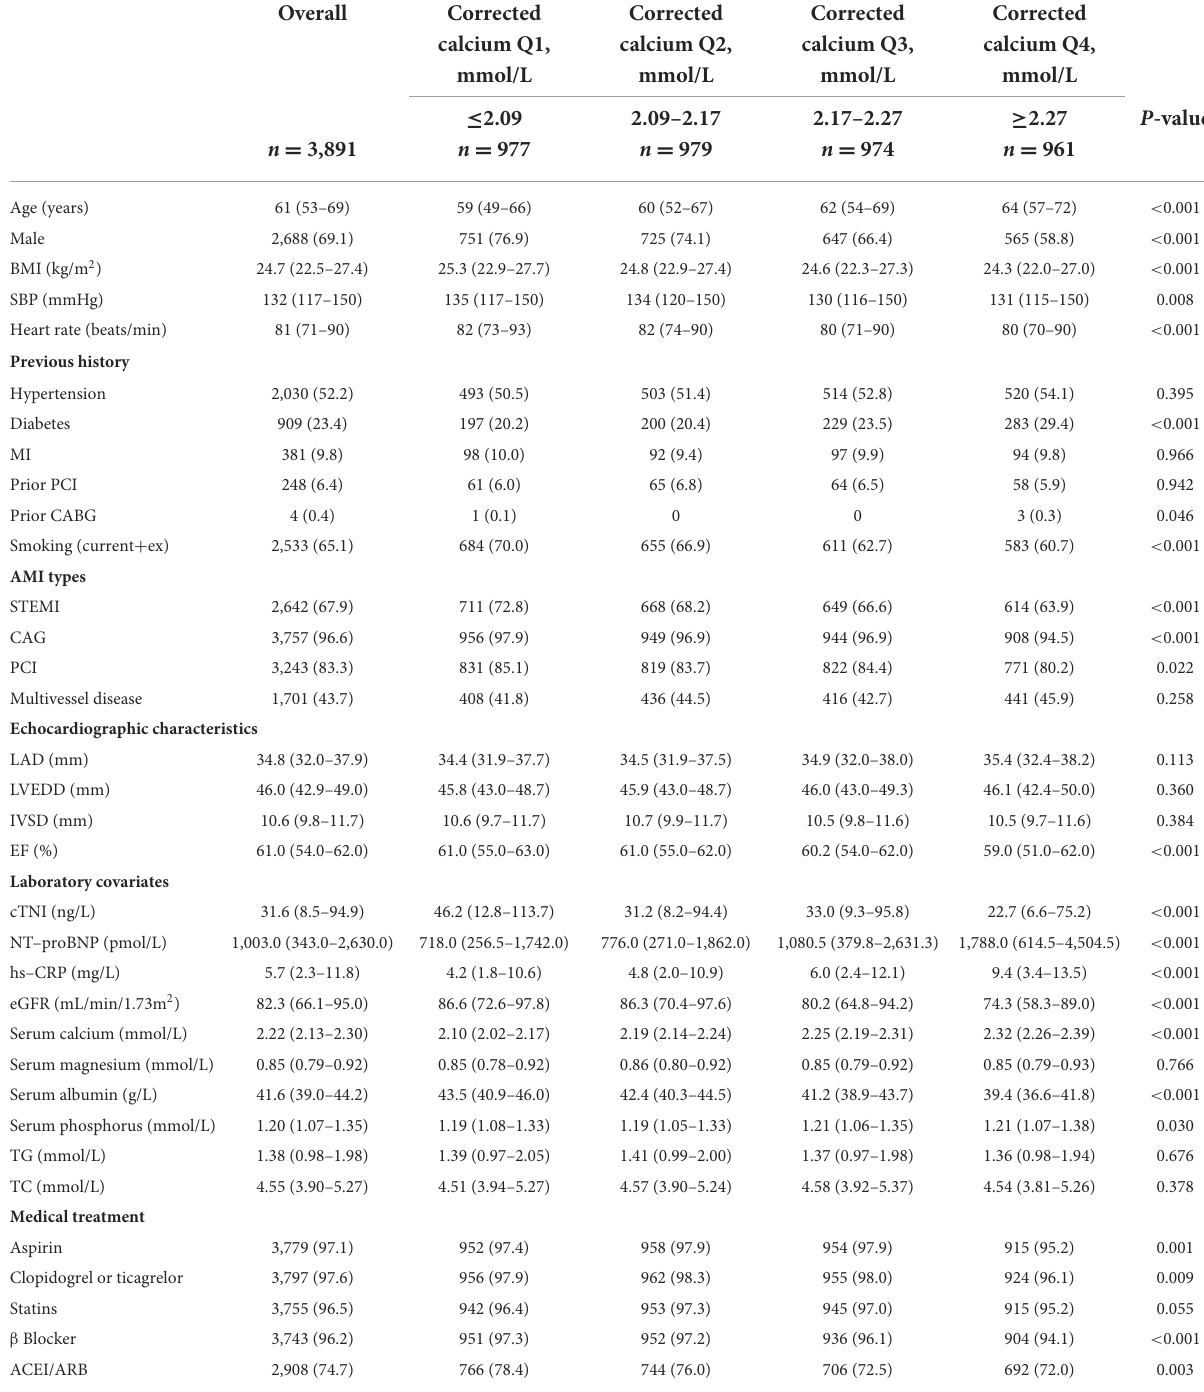
TABLE 2 Participant characteristics by quartiles of corrected serum calcium at